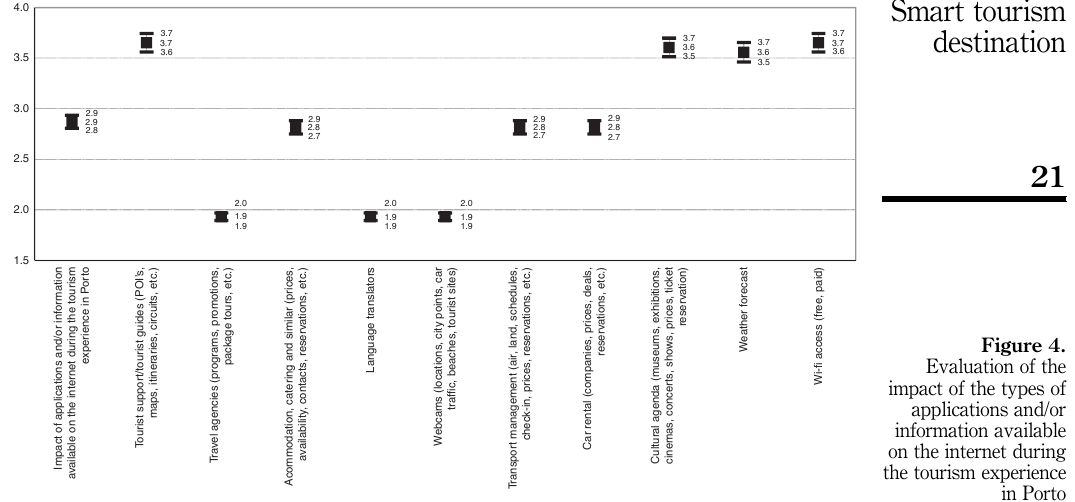
Figure 4. Evaluation of